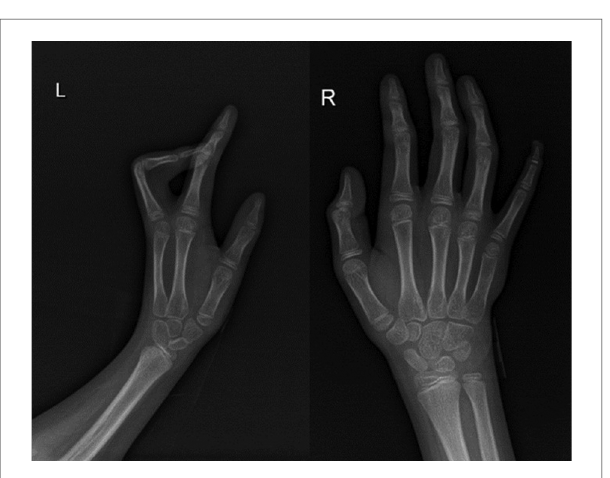
FIGURE 4 x-rayshowing the absence of the left ulna, 4th and 5th metacarpals, and phalanx of the left